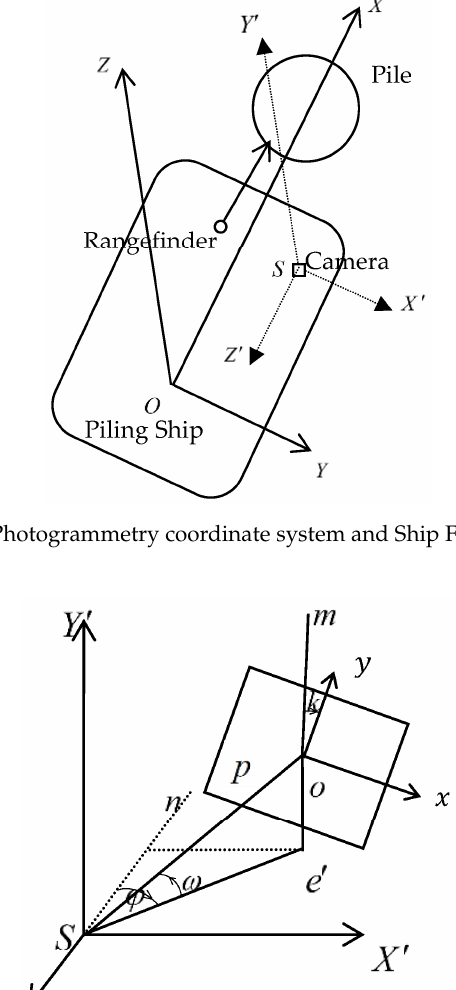
Figure 7. Auxiliary image spatial coordinate system. Remote Sens. 2020 , 12 , x FOR PEER REVIEW